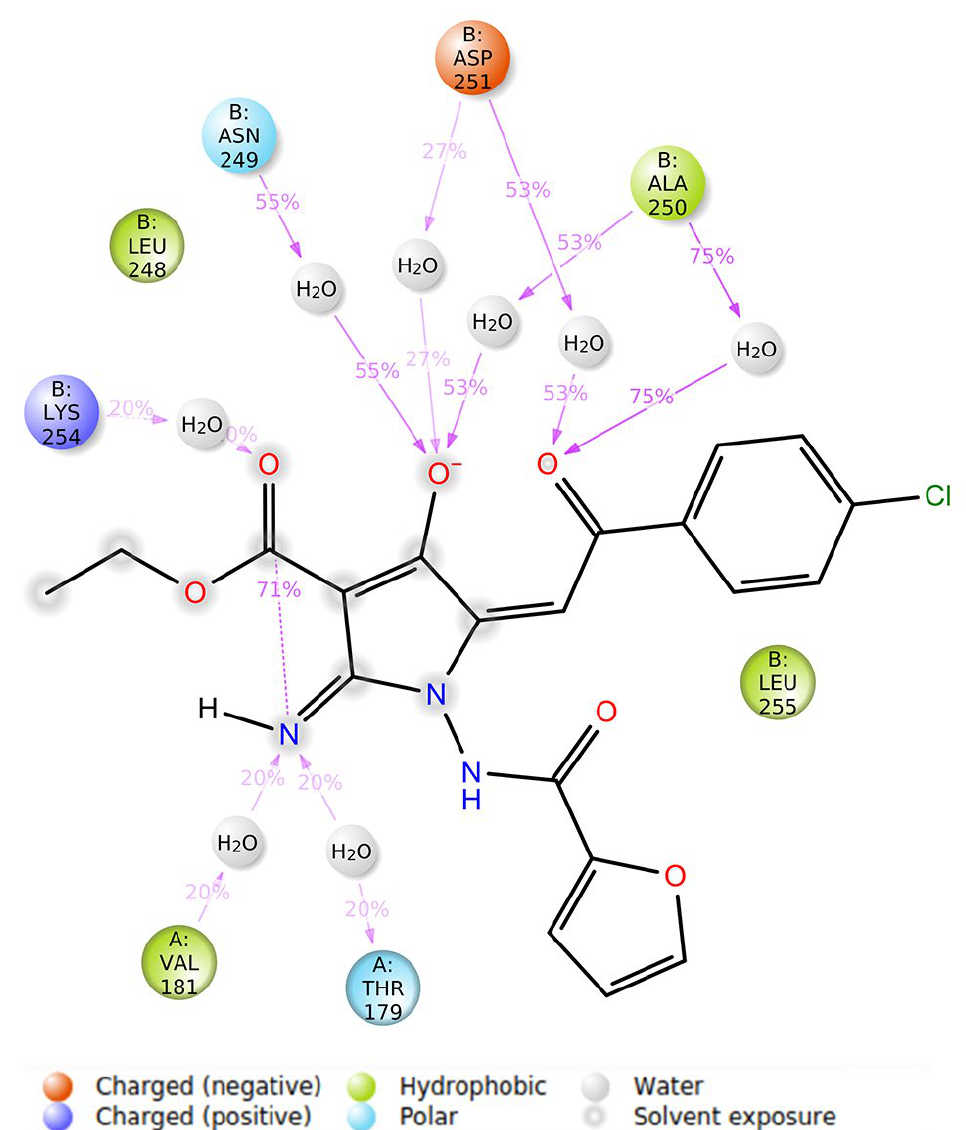
Figure 9. 2D plot of ligand-protein fraction interaction diagram between EAPC-67 and tubulin over 100 nanoseconds MD with labeled key amino acids. Each type of non-covalent interaction is highlighted in the corresponding color.